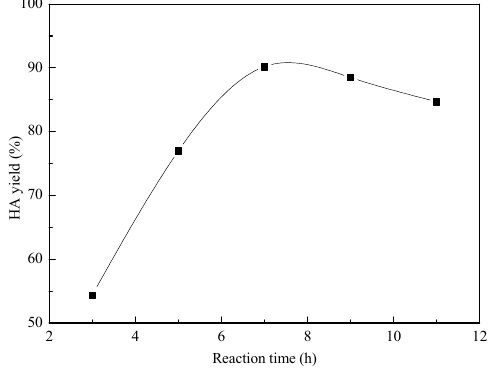
Figure 3. Effect of the reaction time on the HA yield.